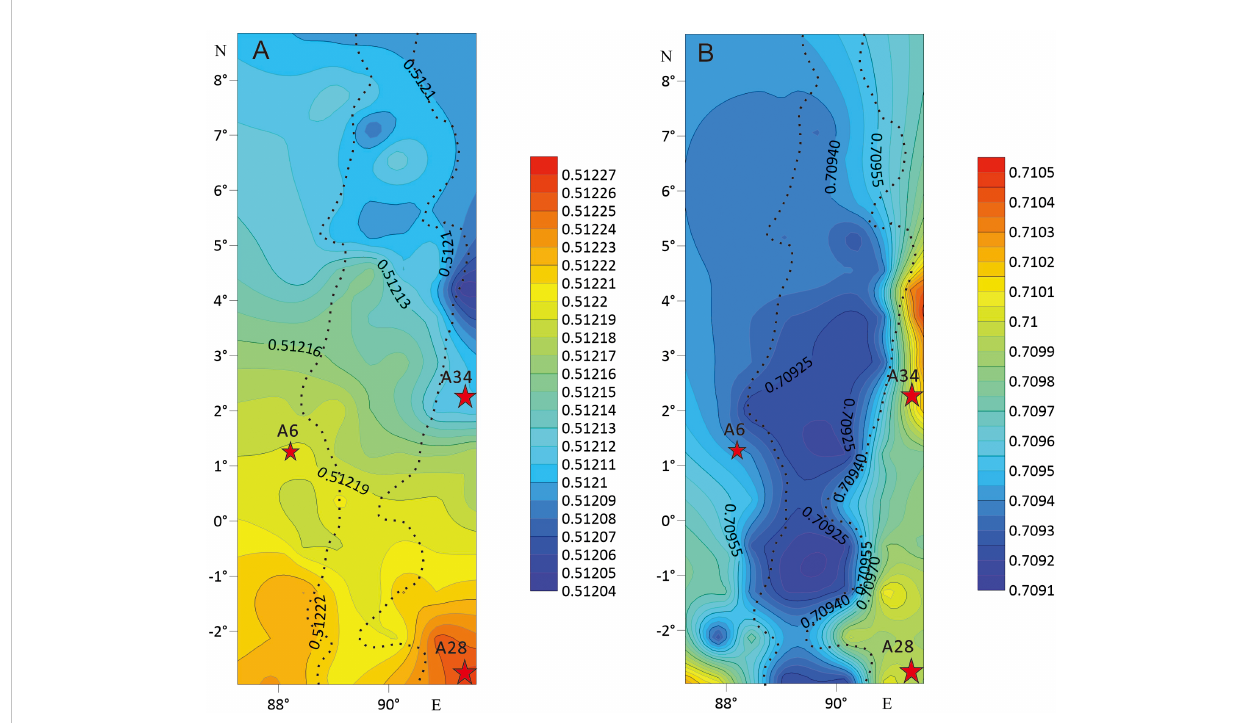
FIGURE 6 143 Nd/ 144 Nd contour map (A) and 87 Sr/ 86 Sr contour map (B) in the study area. (Note: The dotted line represents the position of NER, and the asterisk represents the core sample